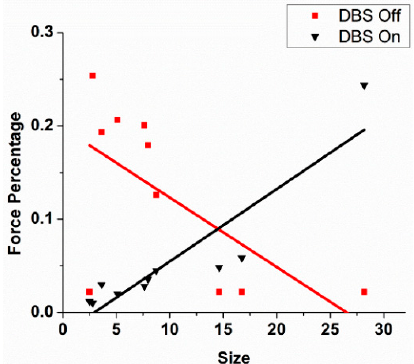
Figure 5. An example of the relationship between the size of the motor units and the percentages of maximum voluntary force at which the motor unit was recruited. In the DBS Off condition, the recruitment is opposite that predicted by the Henneman Size Principle. The recruitment became what would normally be expected by the principle.